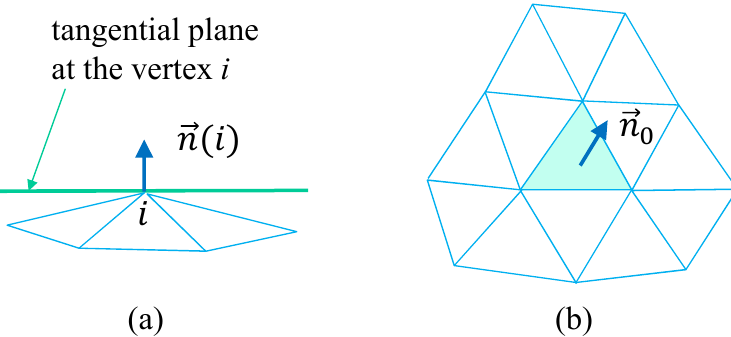
Figure 4. Lattice structure for discretization of the modified canonical surface model. ( a ) The tangential plane at the vertex i and its normal vector n ( i ) , and ( b ) a triangle and its neighboring triangles, where the normal vector n 0 interacts with those of the neighboring triangles. The range of interaction is slightly larger than that shown in Figure